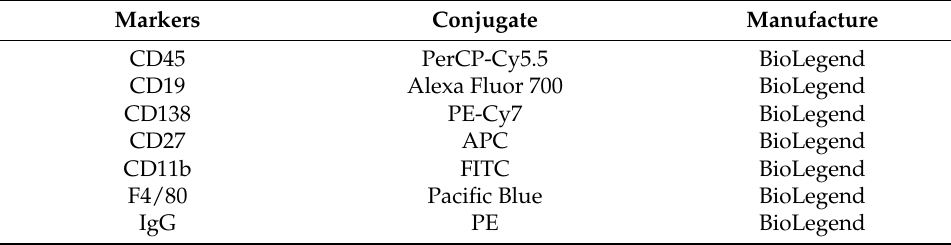
Table 2. The fluorophore conjugates and manufacture of cell